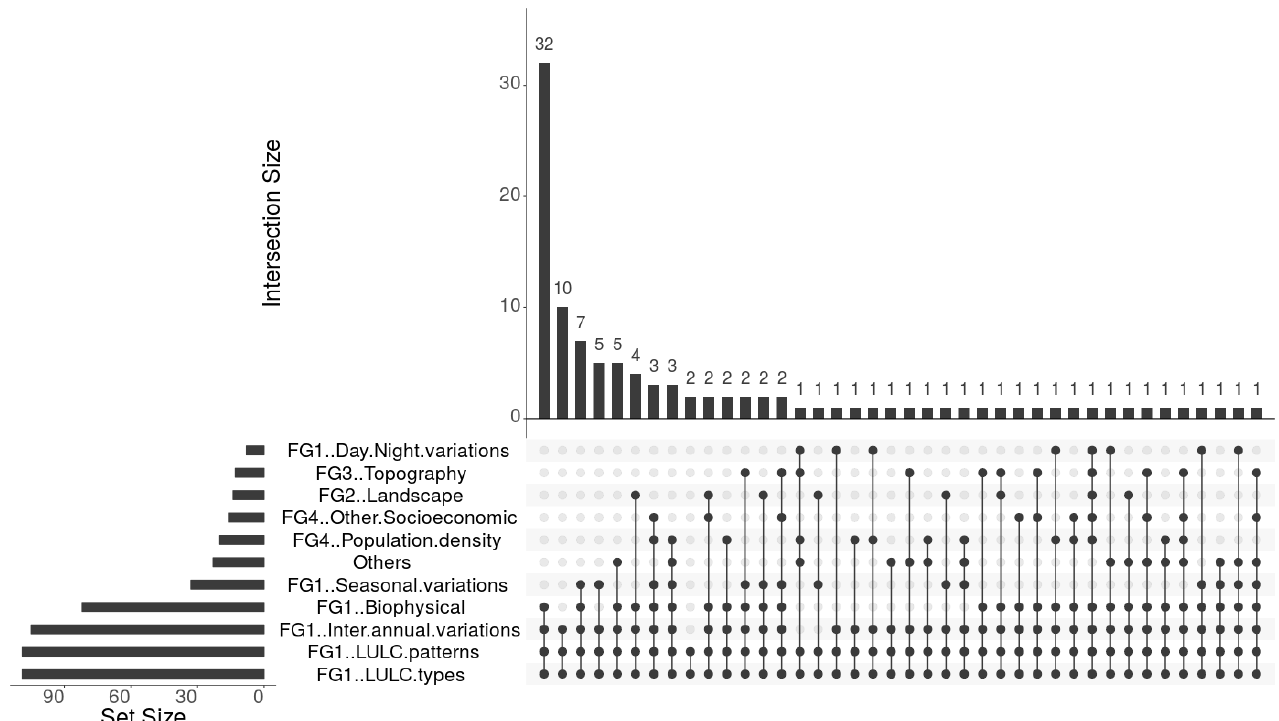
Figure 6. The main SUHI-contributing factors along with the frequency of their combinations, often considered when analyzing SUHI evolutions in the reviewed literature. FG refers to the main group each factor belongs to as follows: FG1: LULC types and their spatiotemporal dynamics; FG2: landscape composition and configuration; FG3: terrain characteristics; and FG4: socioeconomic factors.